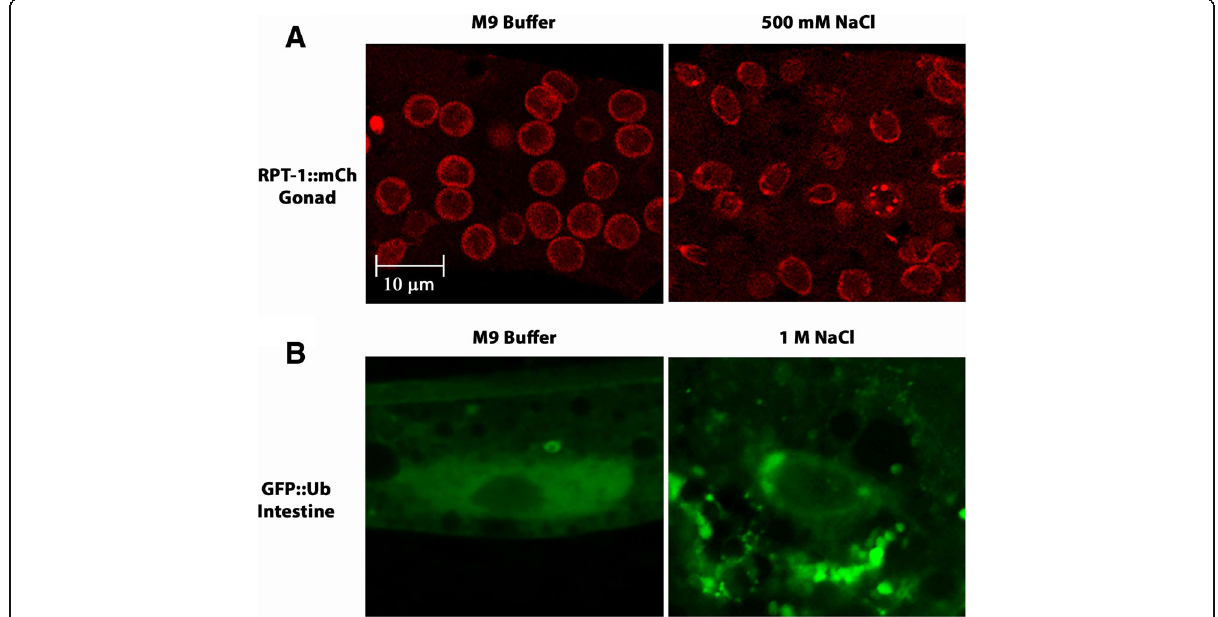
Fig. 8 SING formation does not require intertissue signaling. a Young adult worms expressing RPT-1::mCh were cut open in either M9 buffer or 500 mM NaCl to extrude the gonads from the body. Carcasses containing the other tissues were quickly removed. Gonads were imaged after 60 min. All gonads soaked in 500 mM NaCl formed SINGs (134/300 nuclei; 10 gonads). No SINGs were formed in the gonads soaked in M9 (0/300 nuclei; 10 gonads). Data were collected from 3 independent experiments ( n = 10 worms). b Intestinal cells also form SINGs when separated from the body. Intestinal nuclei are large and polyploid and have an elongated shape. Worms expressing GFP::Ub in the intestine were cut open in either M9 buffer or 1 M NaCl to extrude the intestine from the body. Carcasses containing the other tissues were quickly removed. Intestines were imaged after 60 min. No intestines soaked in M9 formed SINGs (0/40 nuclei; 8 intestines). For intestines soaked in 1 M NaCl, all intestines showed SINGs (14/30 nuclei; 8 intestines). Data were collected from 2 independent experiments ( n = 8 worms). Scale bar indicates 10 μ